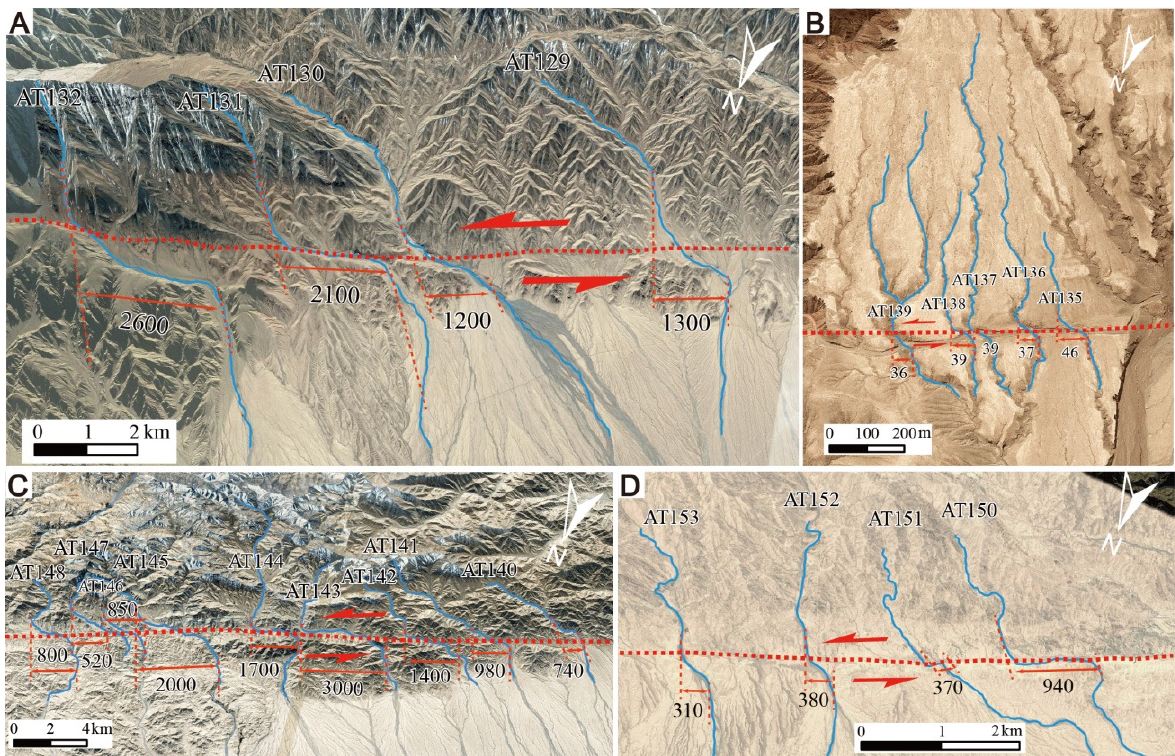
Figure 7. ( A – D ) Google earth images showing the tectonic geomorphology and systematic deflection of stream channels associating with left-lateral strike-slip faulting along Altyn Tagh Fault (see Figure 1B for location, Table S1 for measurement uncertainty). All the offsets are in meters.